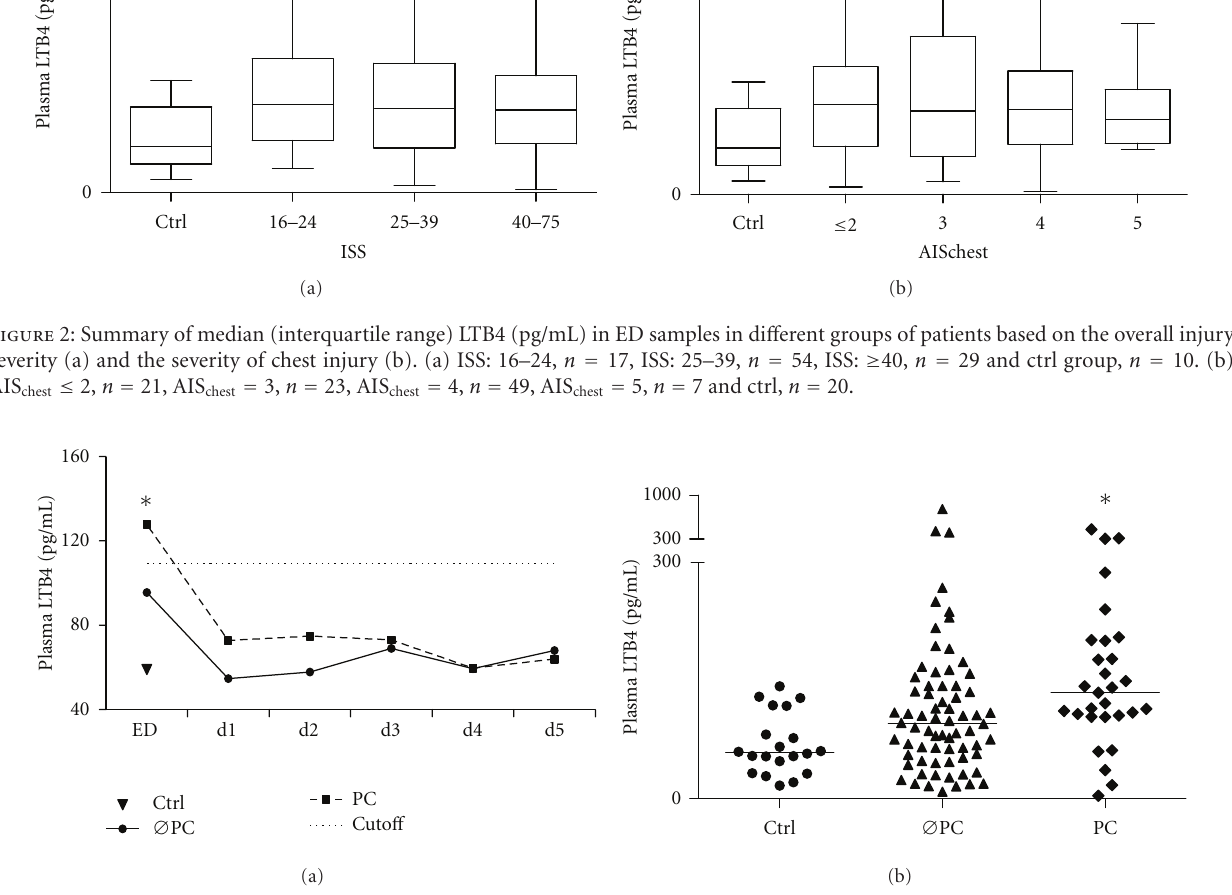
Figure 3: Summary of median LTB4 (pg/mL) in two patient groups based on the development of pulmonary complications (ØPC: no pulmonary complications, n = 70, and PC: pulmonary complications, n = 30) and ctrl, n = 20, ∗ P < 0 . 05 versus other groups: (a) time course in both groups, (b) LTB4 levels at the